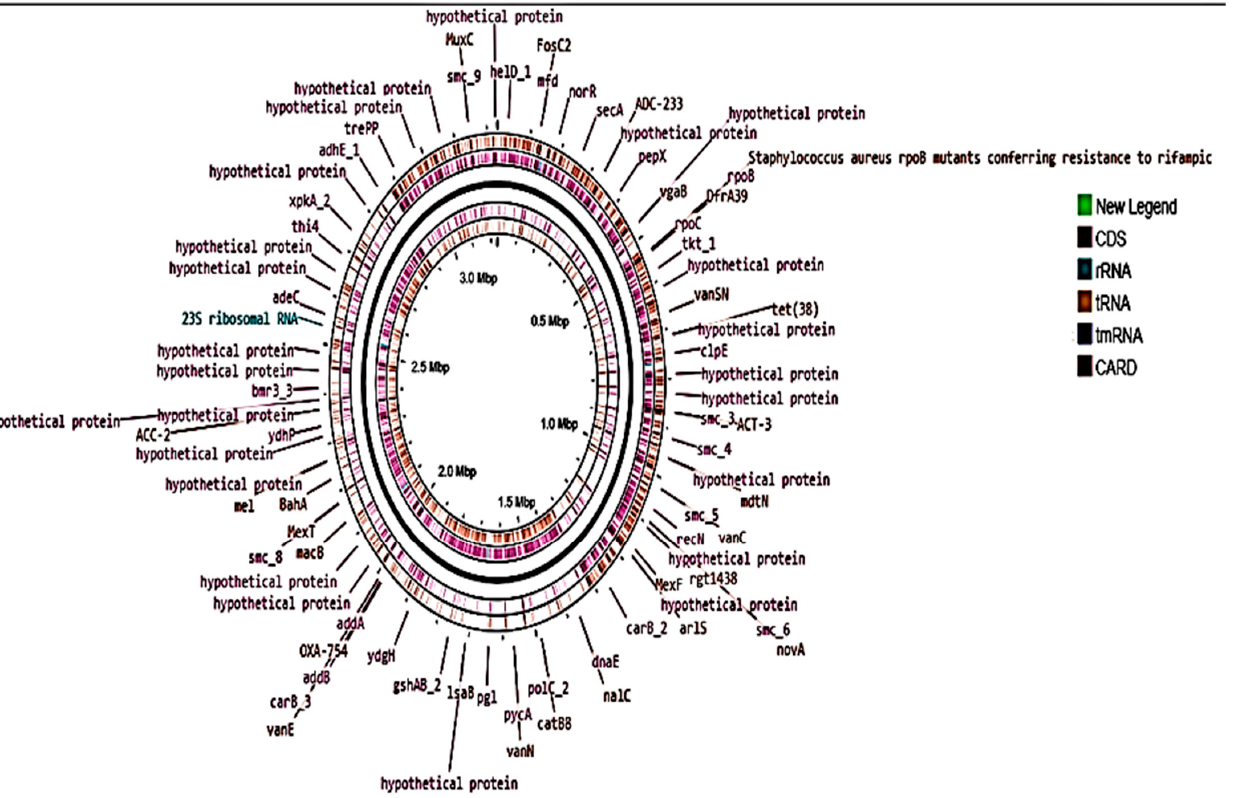
Figure 6. Graphical representation of functionally annotated L. plantarum 13 ‐ 3 genome via GC ‐ Viewer.